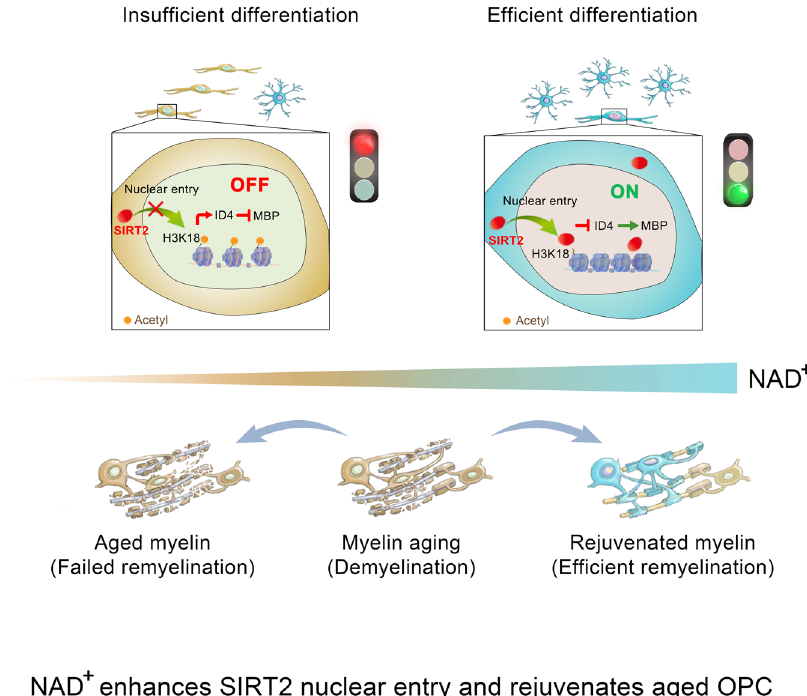
Fig. 8 A working model for NAD + on rejuvenating the aged OPC. NAD + targets OPCs and restores SIRT2 nuclear localisation in aged OPCs and delays myelin ageing and enhances myelin repair following demyelination in the aged